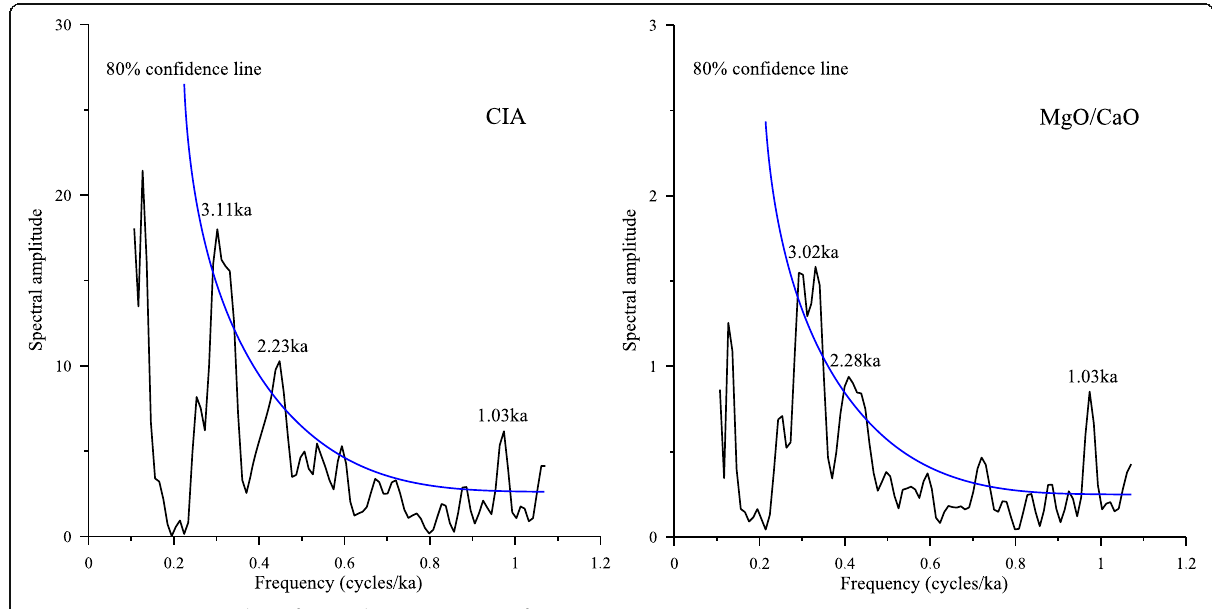
Fig. 8 Power spectrum analysis of CIA and MgO/CaO proxies from core